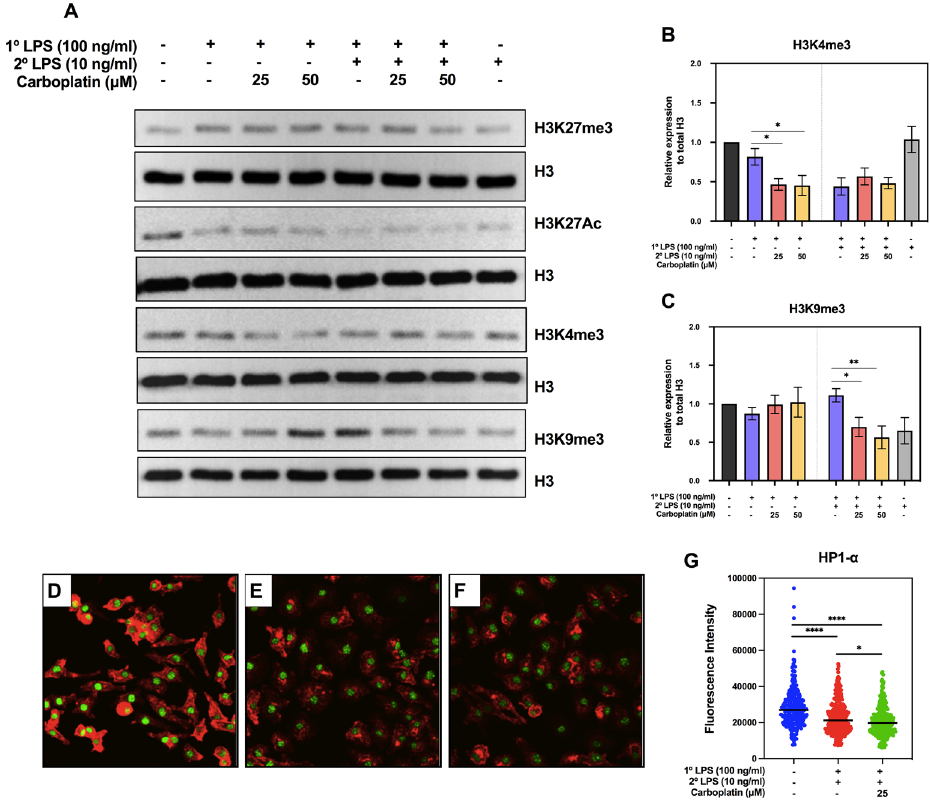
Figure 5. Effects of carboplatin on global histone modification profiles and the level of HP1-α. ( A ) Histone modification profiles of LPS-primed and LPS-tolerant macrophages with or without carboplatin are shown. Methylation profiles of H3K27me3, H3K27Ac, H3K4me3, and H3K9me3 expression were analyzed by western blotting. Total H3 was used as control. The data shown are representative blots of replicates (n ≥ 3). ( B , C ) The relative band intensities of H3K4me3 and H3K9me3 were measured by ImageJ analysis and normalized to the total H3 levels. *, ** indicate p < 0.05, p < 0.01, respectively, using one-way ANOVA. ( D – G ) Immunofluorescence staining of HP1-α is shown. BMDMs were stained with rabbit anti-HP1-α antibody and detected using anti- rabbit IgG antibody conjugated to Alexa Fluor ® 488 (green), followed by staining with phalloidin (red). ( D ) Untreated BMDMs, ( E ) LPS-tolerant BMDMs without carboplatin and ( F ) with carboplatin. The images were acquired using a confocal microscope. ( G ) Fluorescence intensity was measured and calculated based on the corrected total cell fluorescence (CTCF) method. The results shown represent the means ± SD, n = 3 and p <